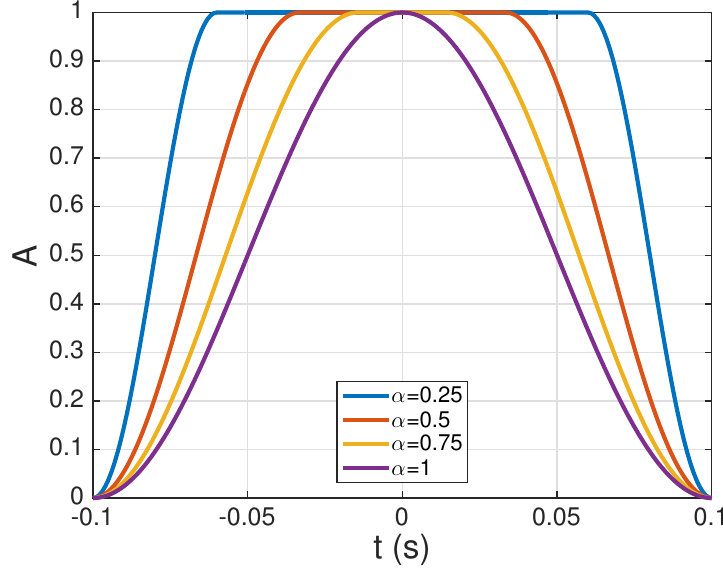
Figure 4. Several examples of the raised cosine window of Equation (11) for T s = 1 ms, L max = 201, and different values of the parameter α